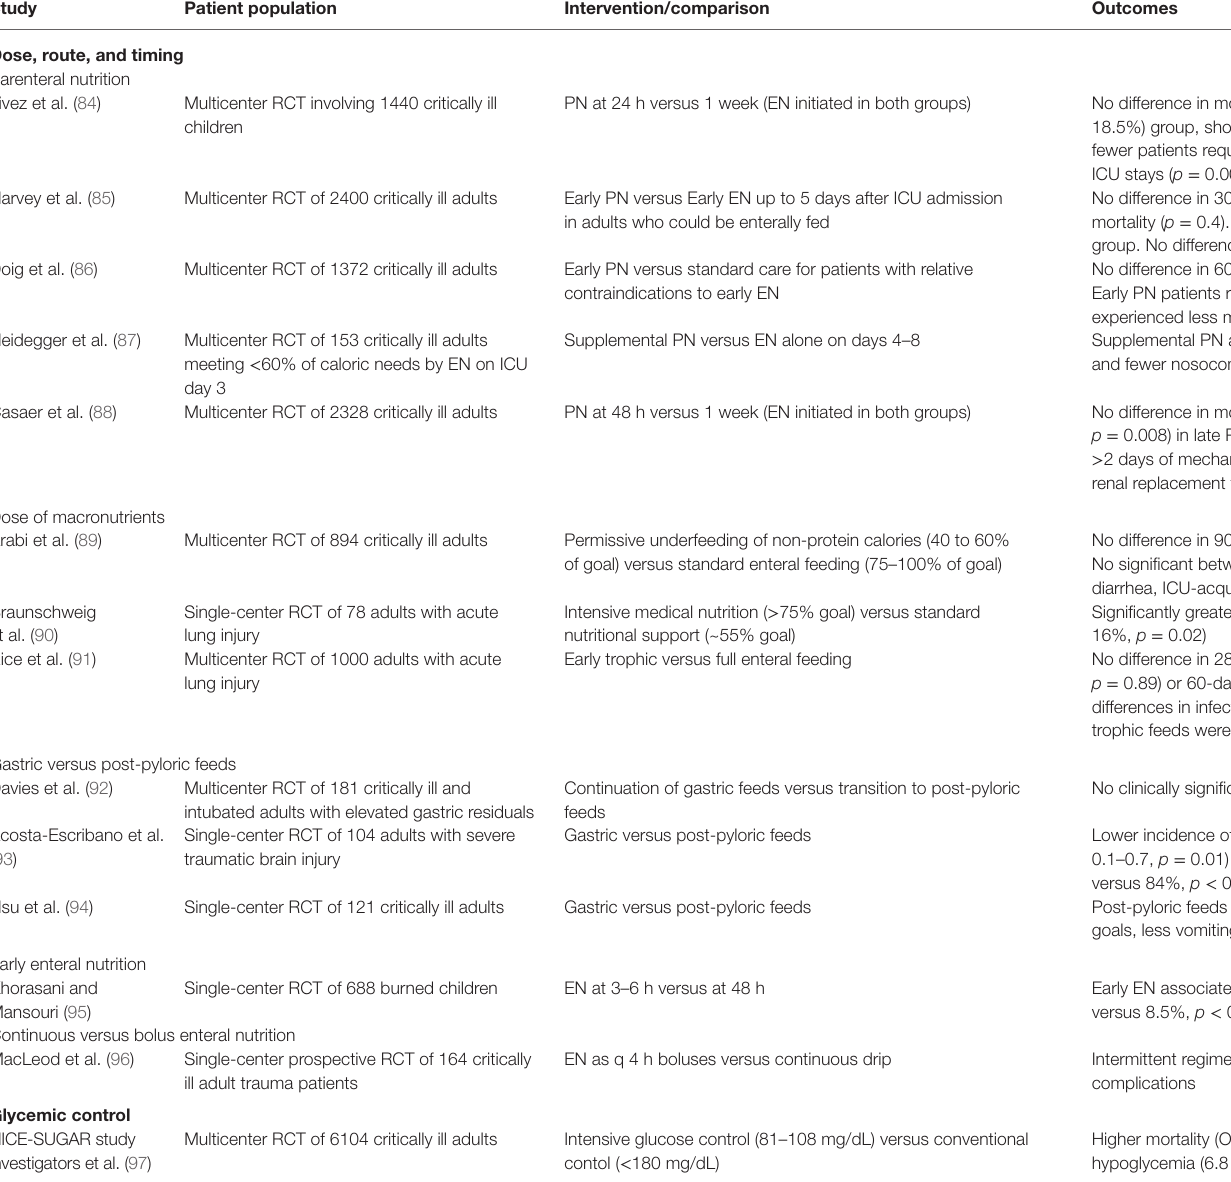
TABLe 2 | Key randomized, controlled trials in critical care nutrition